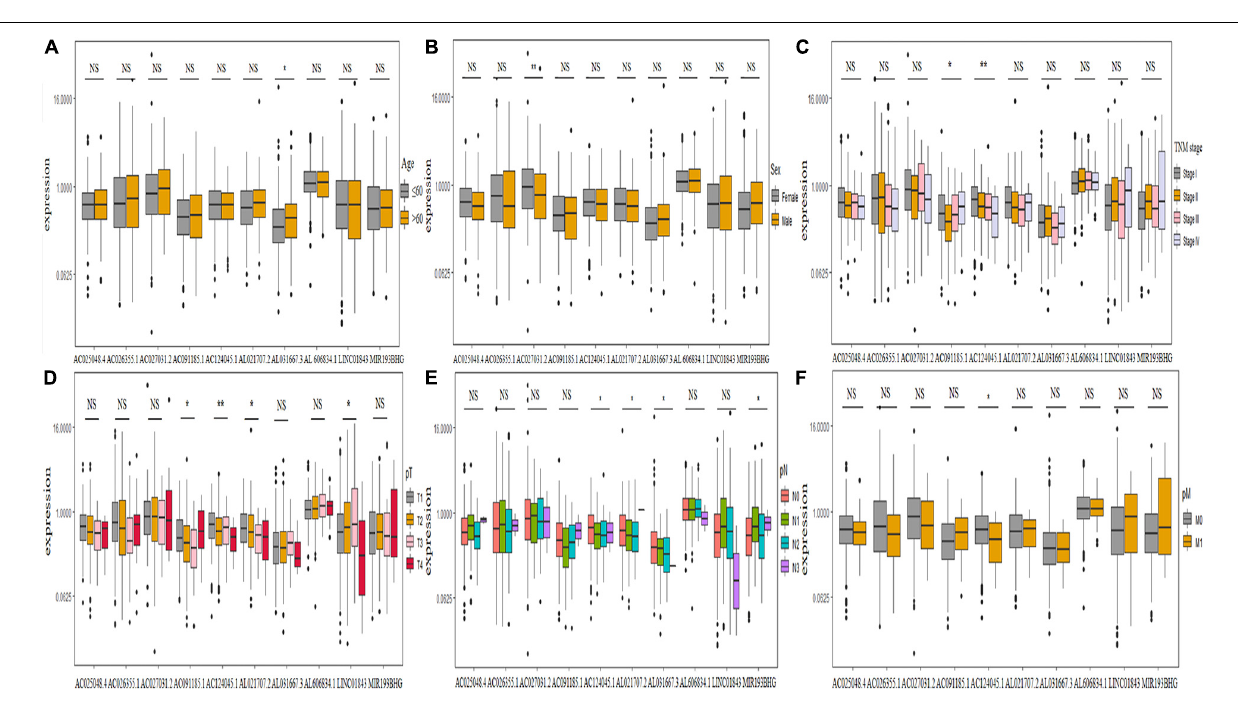
Frontiers in Genetics |